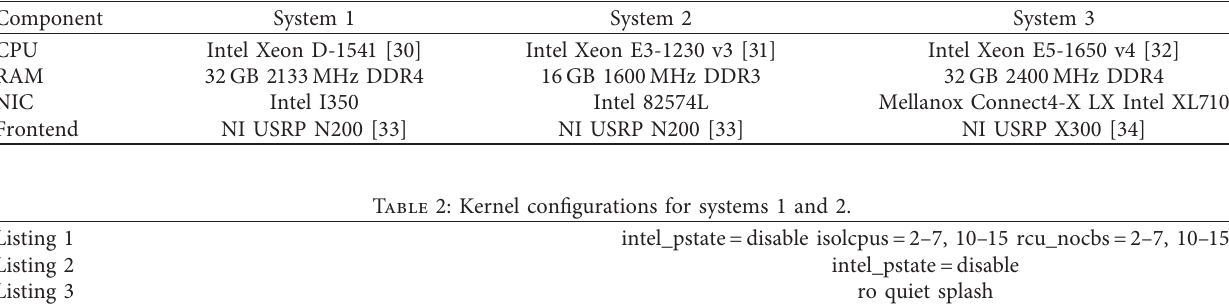
Table 1: Computer system configuration.